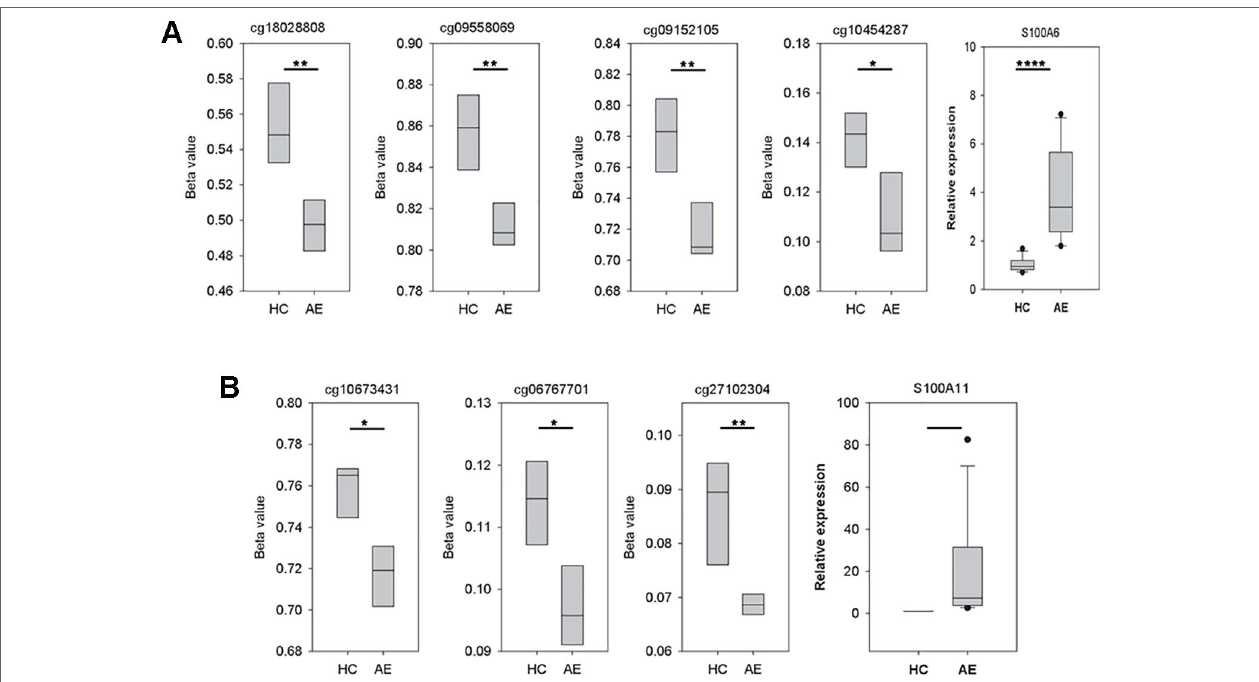
FigUrE 3 | The variations of CpG dinucleotide methylation and gene expression for S100A6 and S100A11. The methylation profiles were determined with M850K assay and the gene expression data was produced by qPCR assay (five AE samples vs. four HC samples). The sequences of forward and reverse qPCR primers for S100A6 were TTCCACAAGTACTCCGGCA and ACCTCCTGGTCCTTGTT, respectively. For S100A11, they were ATTGCTGTCTTCCAGAAGTATG and TTGGTGTCCAGTTTCTTCATC. 18S was applied as internal control with forward and reverse qPCR primers as: GTAACCCGTTGAACCCCATT and CCATCCAATCGGTAGTAGCG. We performed real-time quantitative PCR using the Fast SYBR ® Green Master Mix system and the StepOnePlus™ System (Applied Biosystems). (A) The four CpG dinucleotides, cg18028808, cg09558069, cg09152105, and cg10454287, were in turn located at the −4556, −2178, −917, and